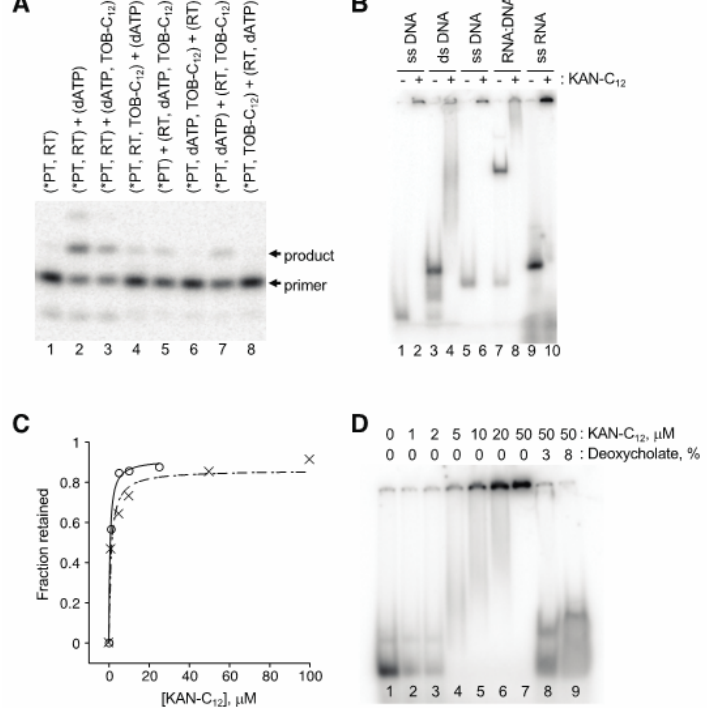
Figure 5. Modified aminoglycosides bind nucleic acids in high ‐ molecular ‐ weight complexes. ( A ) Preincubation of TOB ‐ C 12 with primer:template duplex results in the largest degree of inhibition. Components of the single ‐ nucleotide primer ‐ extension reaction (radiolabeled primer annealed to RNA template, *PT; HIV ‐ 1 reverse transcriptase, RT; dATP; TOB ‐ C 12 ) were pre ‐ equilibrated in separate tubes (denoted by parentheses) for 20 min at 37 °C and then combined (as indicated) and further incubated for 1 min prior to PAGE analysis. ( B ) Gel ‐ shift experiments show that KAN ‐ C 12 forms high ‐ molecular weight complexes with various nucleic acids. A radiolabeled DNA oligonucleotide (18mer, lanes 1–4; 22mer, lanes 5–8), alone or pre ‐ annealed to a complementary strand (as indicated), or an RNA oligonucleotide (25mer, lanes 9–10), was incubated with or without KAN ‐ C 12 (150 M) for 15 min at 25 °C (as indicated) and then subjected to native PAGE. ( C ) Experiments with ultrafiltration devices show that RNA or DNA oligonucleotides form large and stable complexes. Radiolabeled oligonucleotide (DNA, ; RNA, ) was incubated with KAN ‐ C 12 (various concentrations) and the fraction in complexes of >300 kDa was determined by ultrafiltration (300 kDa MWCO). Data were plotted and fit to the equation y = (y max x)/( K D + x) to yield apparent K D values